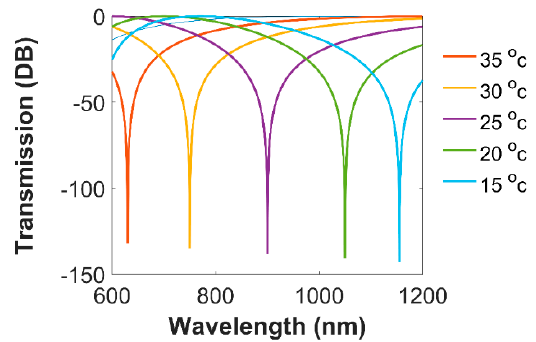
Figure 7. Transmission spectra of the Sagnac interferometer optical fiber sensor as a function of wavelength for different temperatures.